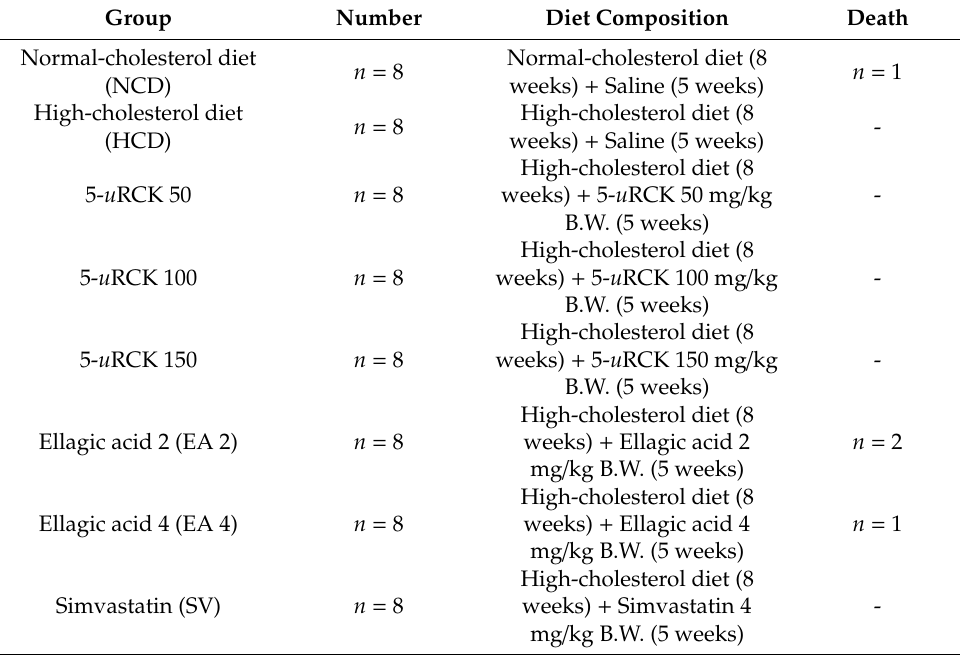
Table 3. Experimental group